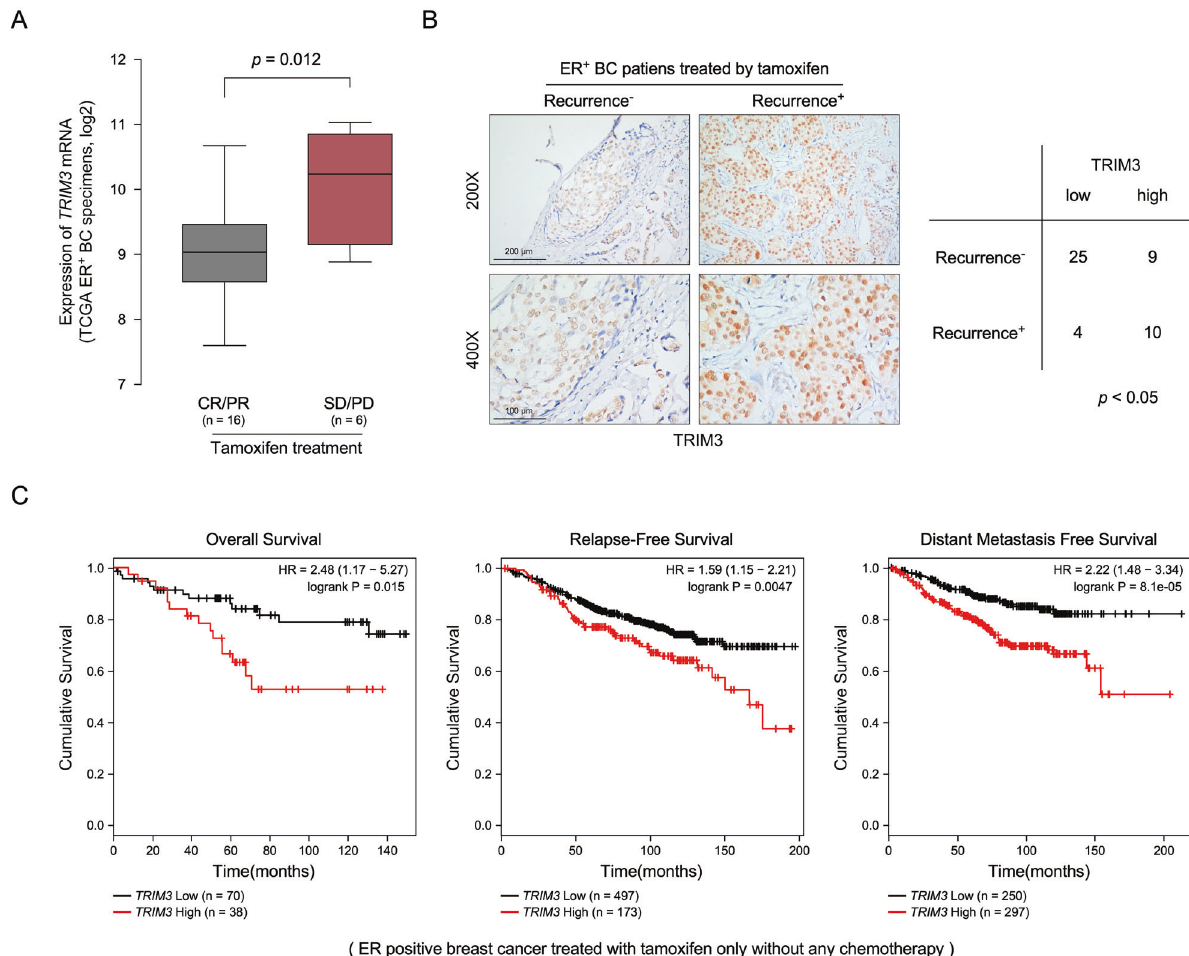
Fig. 1 TRIM3 overexpression promotes tamoxifen resistance in breast cancer. A A boxplot representing TRIM3 expression levels in ER + breast cancer with tamoxifen treatment [SD/PD versus CR/PR, P = 0.012, stable disease (SD), progressive disease (PD), complete remission (CR), partial remission (PR)]. B Representative images of TRIM3 expression in recurrence − and recurrence + ER + breast cancer tissues with tamoxifen treatment (left panel). Scale bars: 200 μ m (upper panel) and 100 μ m (lower panel). The statistical signi fi cance of the TRIM3 levels is assessed in the right panel. P < 0.05. C Analysis of the effect of TRIM3 expression on Overall Survival (OS), Relapse-Free Survival (RFS), and Distant Metastasis-Free survival (DMFS) of ER + breast cancer with tamoxifen